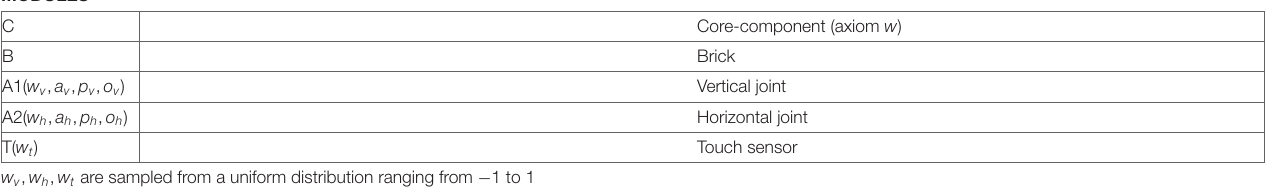
TABLE 1 | Alphabet of the grammars.